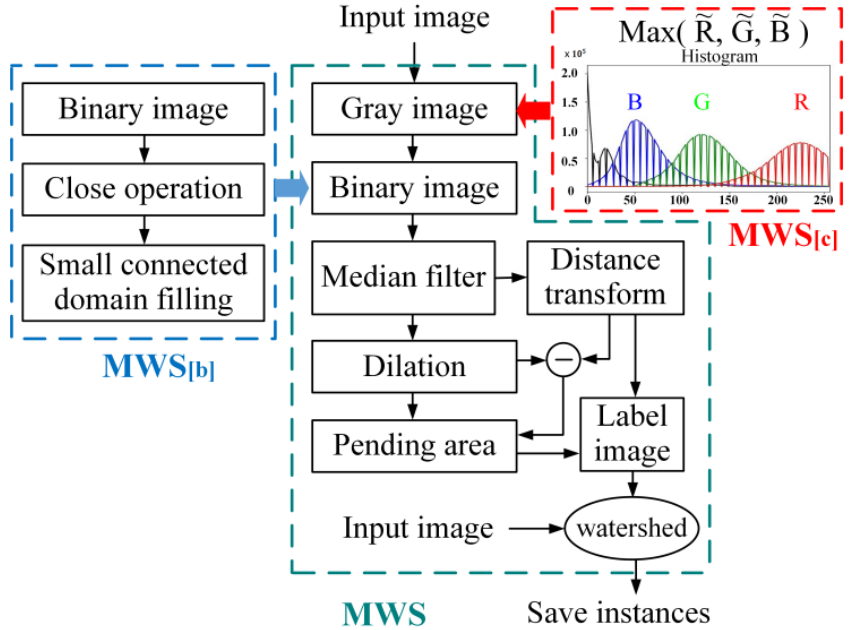
Figure 4. Flow diagrams of MWS and the improved watershed segmentation algorithms (MWS [b] and MWS [c] ). Middle dotted box presents the procedure of MWS, in which the acquisition process of gray image is replaced by the right dotted box representing MWS [c] , and the acquisition process of binary image is replaced by the left dotted frame representing MWS [b]. R, G, B represent the red, green and blue channel of the input image, respectively.